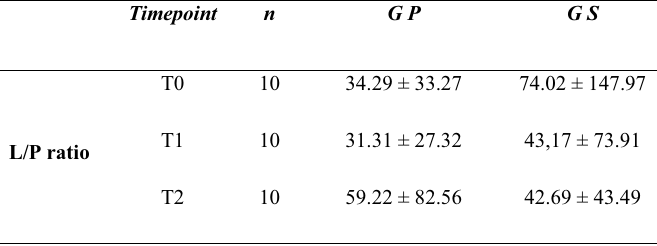
TABLE 2 - Lactate / pyruvate (L/P) means ratio in children anesthetized with Propofol (GP) or Sevoflurane (GS). Values expressed as mean ± SD in both groups.